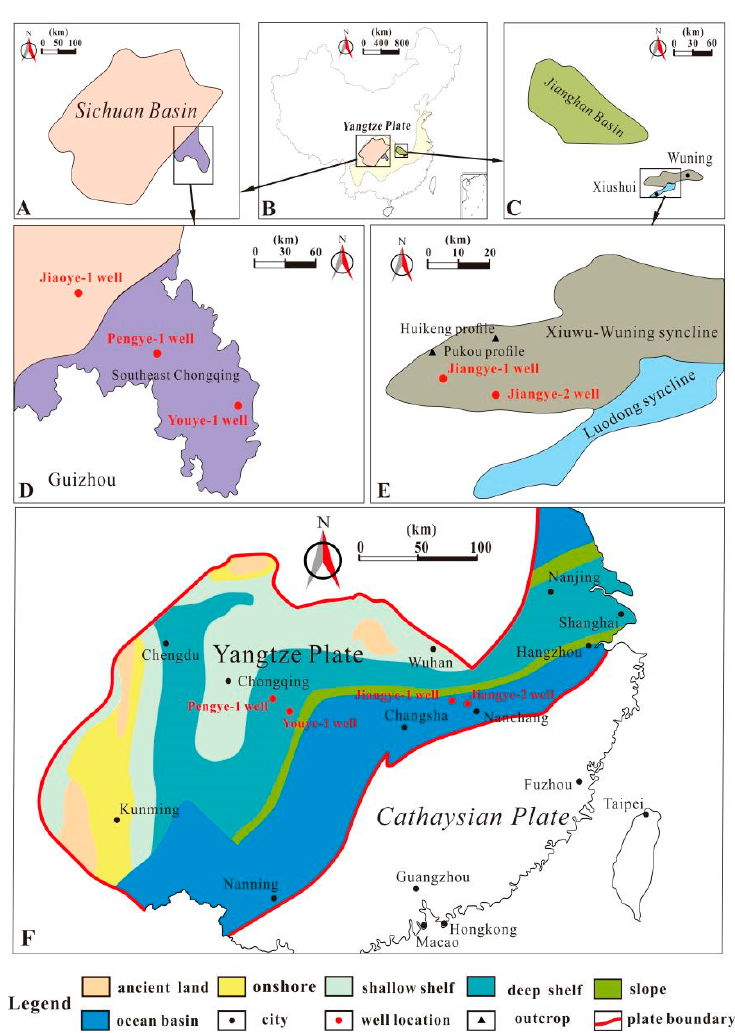
Figure 1. Geological maps of the research areas. ( A , D ) Geographical location maps of Southeast Chongqing. Pengye-1 and Youye-1 wells are located in this block, and Jiaoye-1 well is located in the Sichuan Basin. ( B ) Geographical location map showing Southeast Chongqing region in Upper Yangtze area and Xiuwu Basin in Lower Yangtze area. ( C , E ) Geographical location maps of Xiuwu Basin. Jiangye-1 and Jiangye-2 wells are located in this block, which is closest to the junction of the Yangtze and Cathaysian plates. ( F ) Map of sedimentary features of Yangtze plate in Early Cambrian.